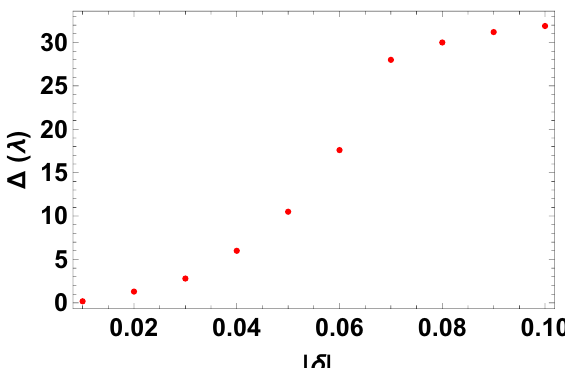
Figure 6. Particle separation of particles with different chiral parameter δ , when we use the de-phasing parameter τ = 10 Hz, taking in all cases a final time of 50